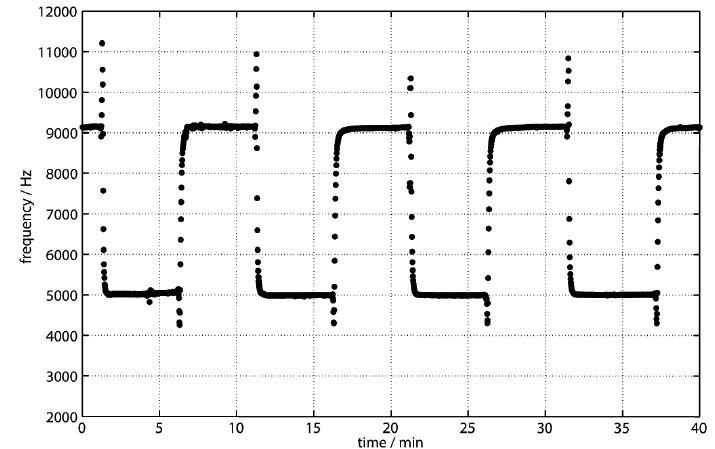
Figure 4. Raw data of the pressure testing tank calibration (2 MPa). Frequency (Hz) as a function of time (min) during the measurement of the blank (higher frequencies) and standard (lower frequencies) solution (Mn(II) = 5 µ M). Frequencies are proportional to the light intensity detected by the light-to-frequency